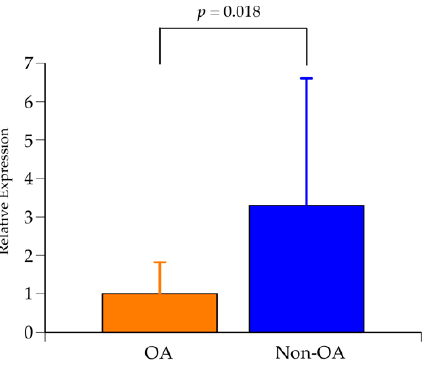
Figure 4. GCH1 expression in 14 non-OA patients and 14 OA patients by qualitative real-time polymerase chain reaction. OA: osteoarthritis. p = 0.018 by Student’s t -test.